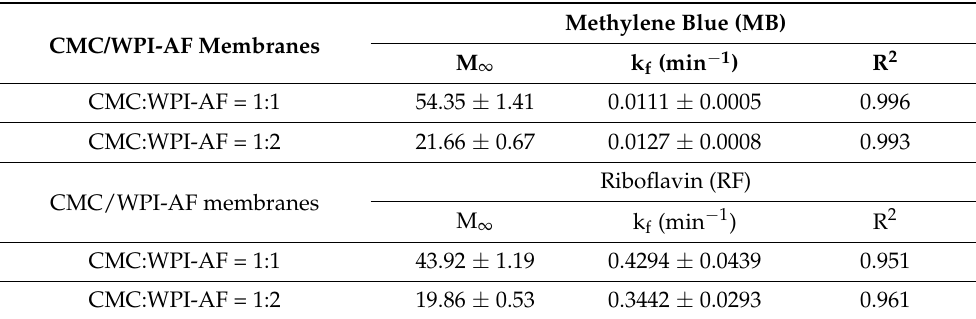
Table 2. Estimates of the first order model parameters for MB or RF release from CMC/WPI-AF membranes synthesized at CMC:WPI-AF mass ratios of 1:1 and 1:2.